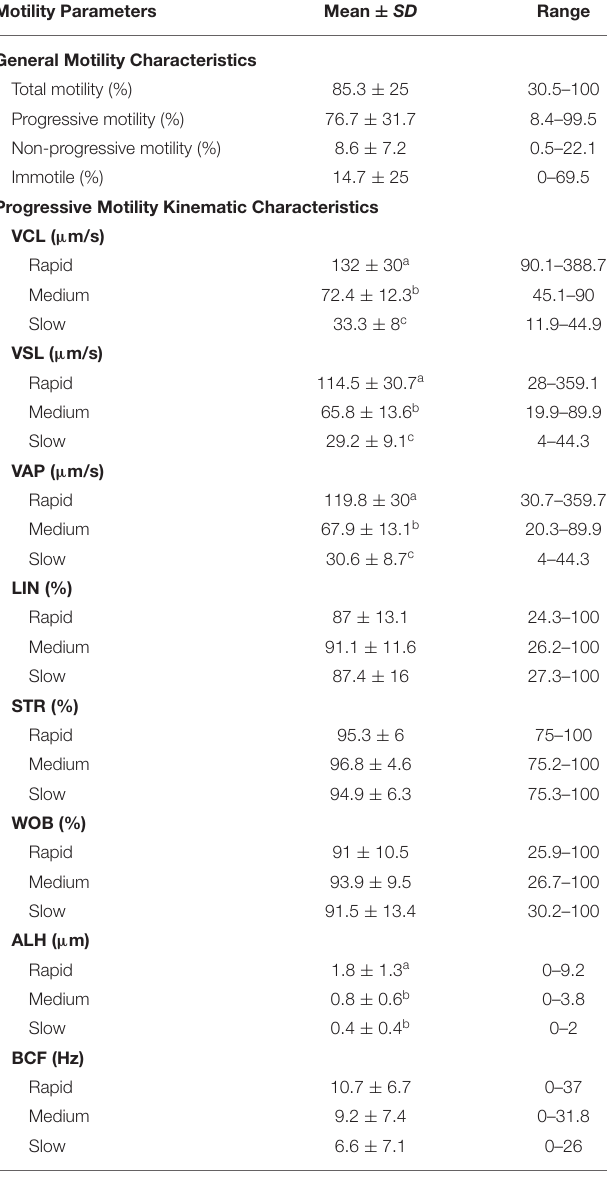
TABLE 2 | Motility and associated kinematic parameters across all ejaculate samples ( n = 7).